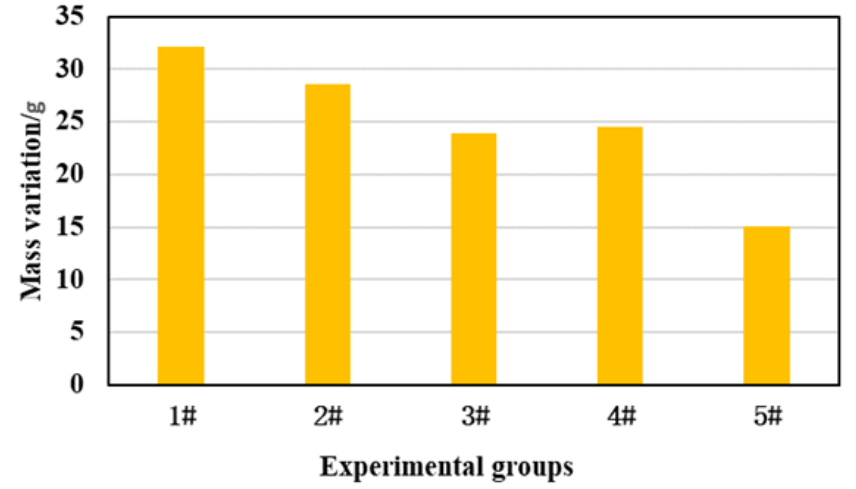
Figure 7. Mass of acid-etched rock slab.